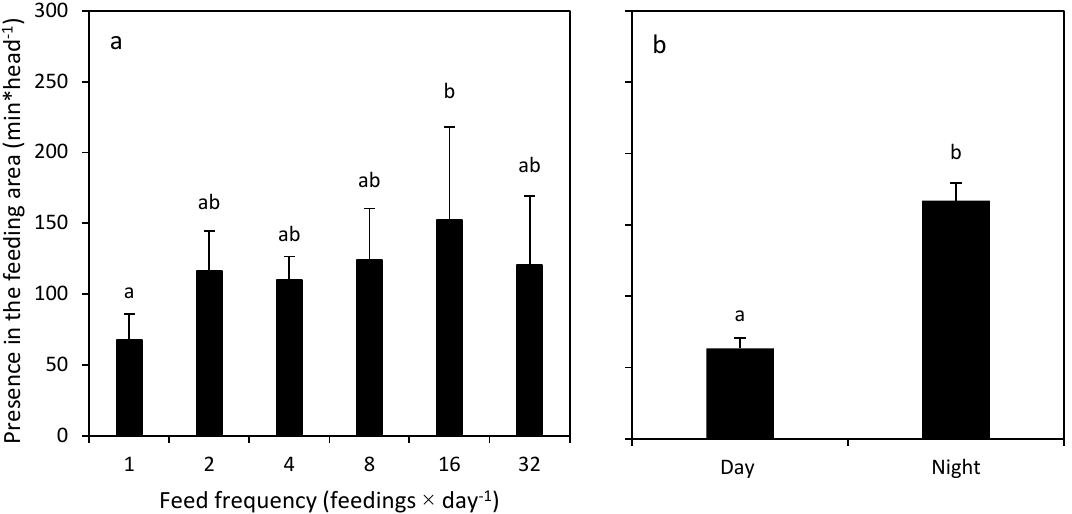
Figure 5. Effect of feed frequency on sum of Panulirus ornatus presence in the feeding area. The graph shows mean values ± S.E. The arrow shows optimal feed frequency (F opt ) for the highest sum of lobster presence in the feeding area.